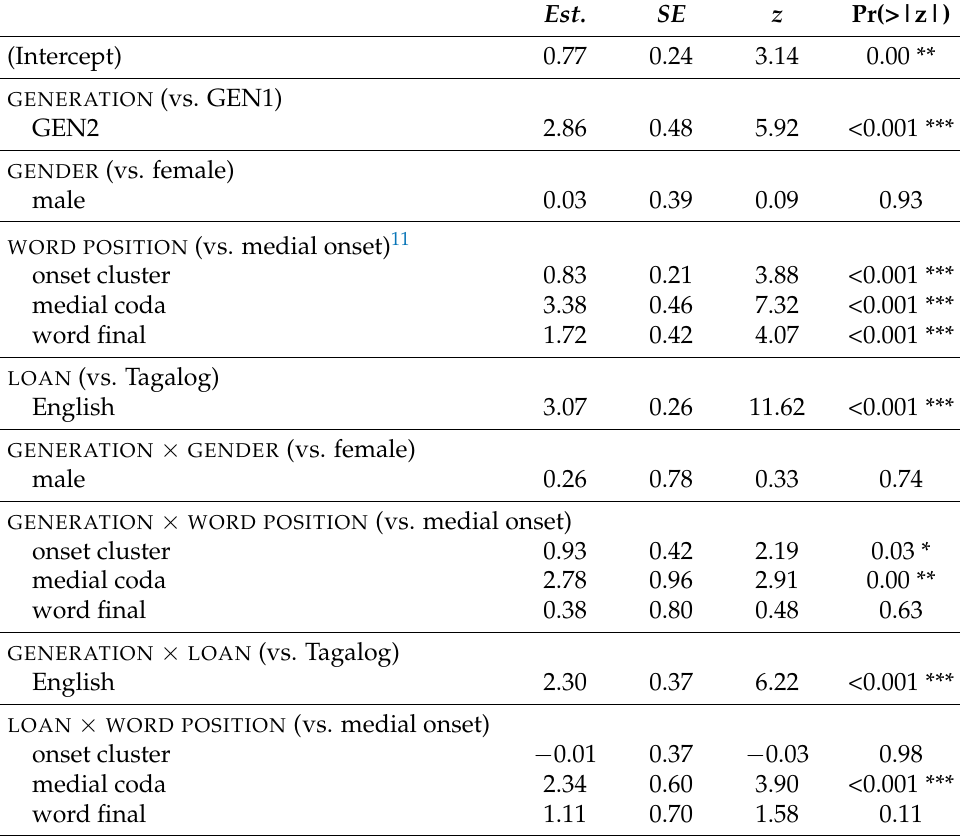
Table 9. Mixed-effects model for GEN1 and GEN2 speakers (n = 1852). Positive estimate values indicate a favoring environment for the approximant. Significance codes: <0.001 ‘***’; <0.01 ‘**’; <0.05